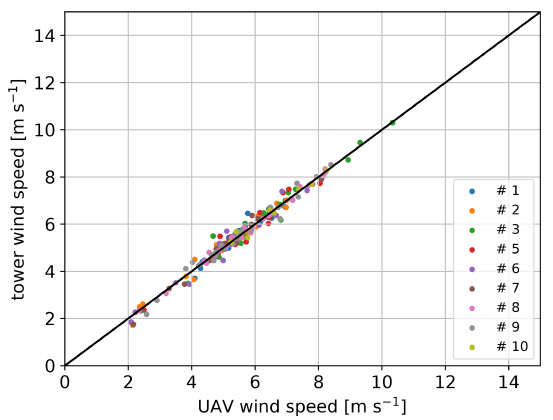
Figure 4. Regression function used for determining one universal set of parameters for c p , c d , 0 A 0